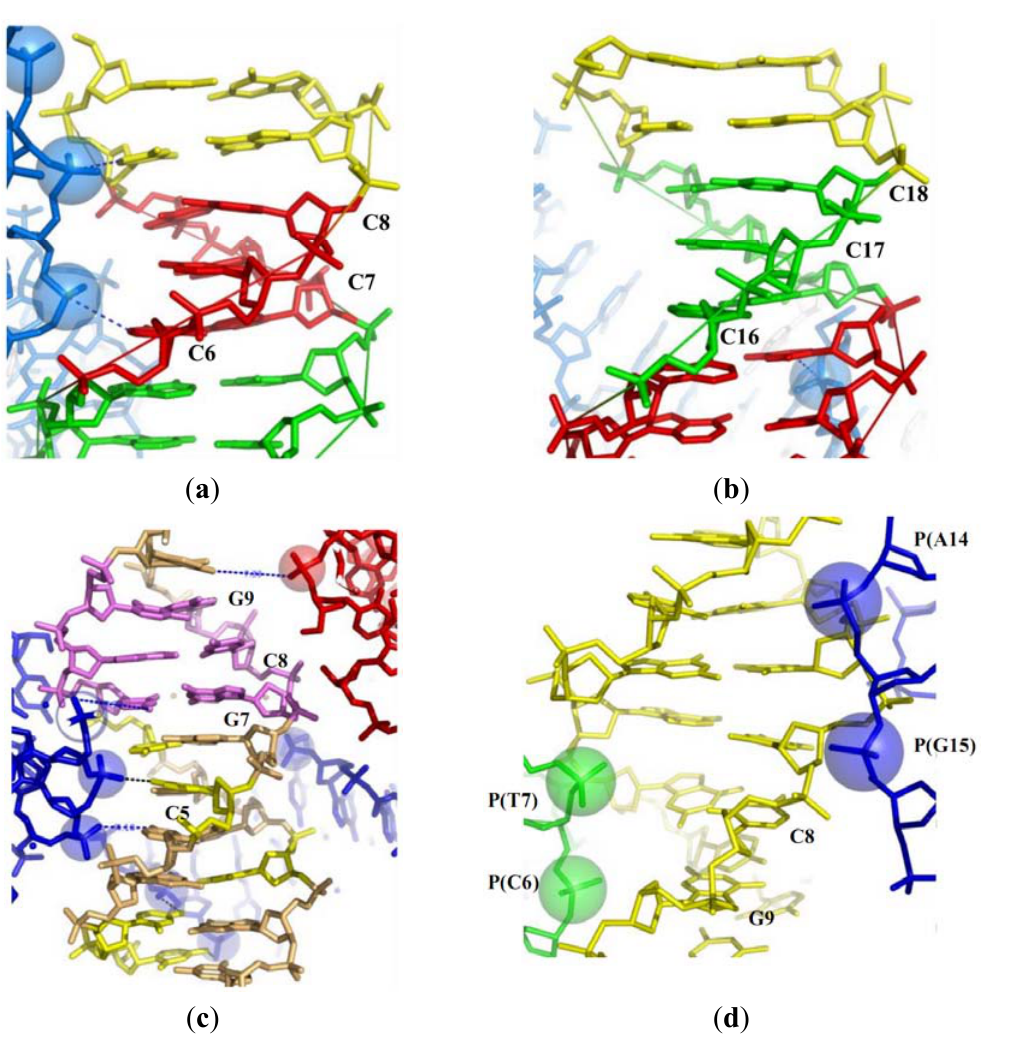
Figure 2. Packing-induced base stacking alterations. ( a ) The half of the palindromic decamer d(CCIIICCCGG) (I denotes an inosine) exposed to three phosphate groups of a symmetry related molecule that form a left-handed cross; ( b ) The free half of the decamer; ( c ) the structure of the decamer d(CCGCCGGCGG) surrounded by the three symmetry related molecules; ( d ) The structure of the decamer d(CCGAGCTCGG) showing the backbone of two symmetry related molecules deeply inserted in the minor